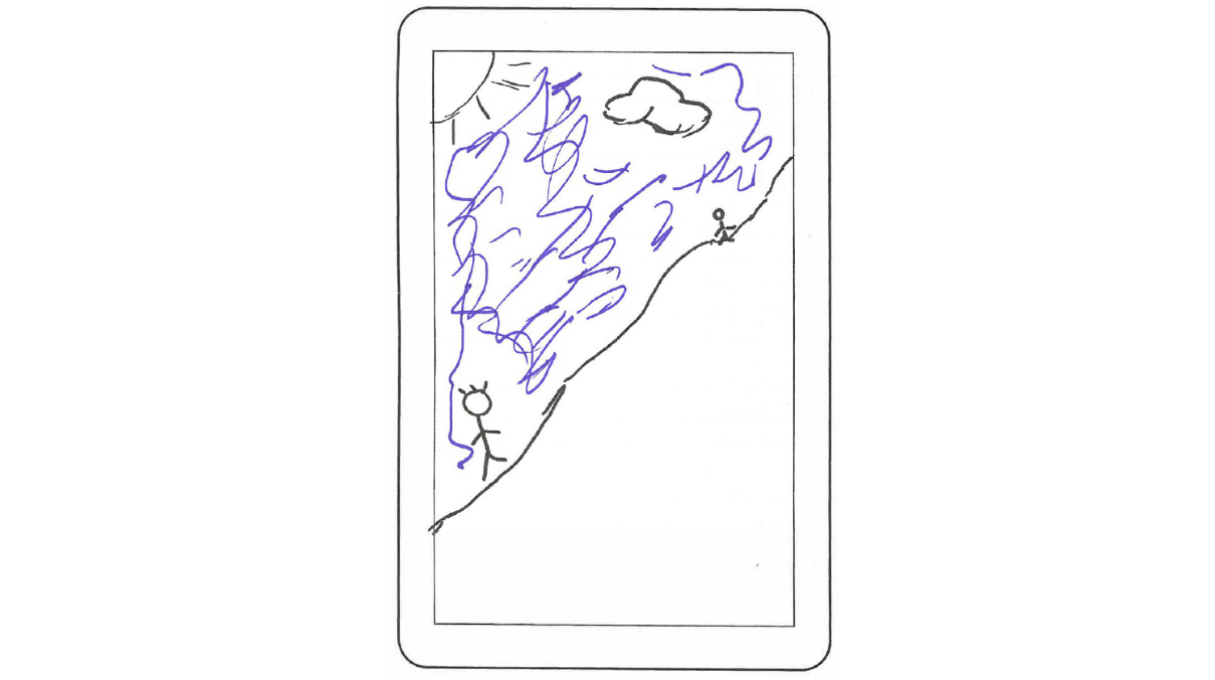
Figure 4. User sketch of